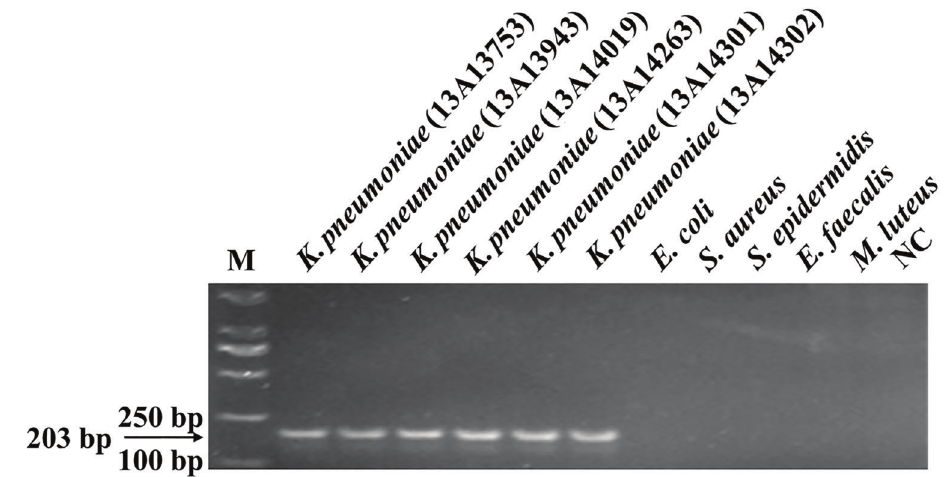
Figure 1. Speci fi city of the PCR assay for detecting the target gene ureR_1 using the primers B3/F3. Genomic DNA of K. pneumoniae was used as the template for PCR in lane 2 to lane 7; the template in lane 8 to lane 12 were ordinal of control strains, E. coli , S. aureus , S. epidermidis , E. faecalis , M. luteus . M: 2000 marker; NC: negative control, with sterile distilled water as the template. All experiments were repeated